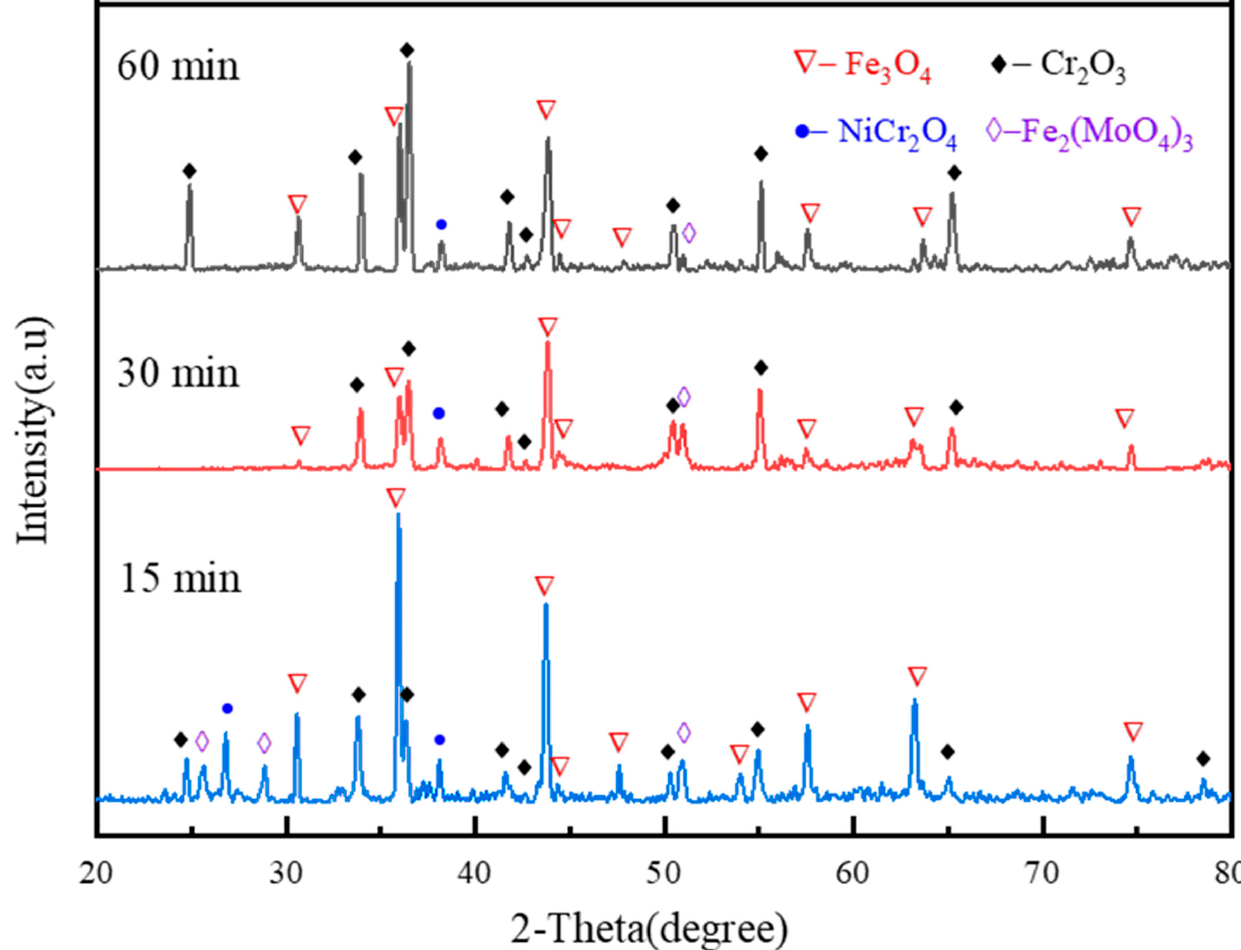
Figure 4. Surface XRD patterns for the FeCoNiCrMo coatings after oxidation at 1100 °C for 15 min, 30 min, and 60 min in a steam environment. Table 3. Fraction of phases based on XRD after oxidation at different times.